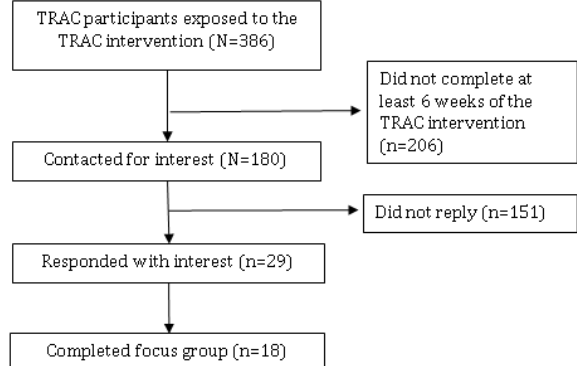
Figure 1. Flow diagram of focus group participants. TRAC: Texting to Reduce Alcohol